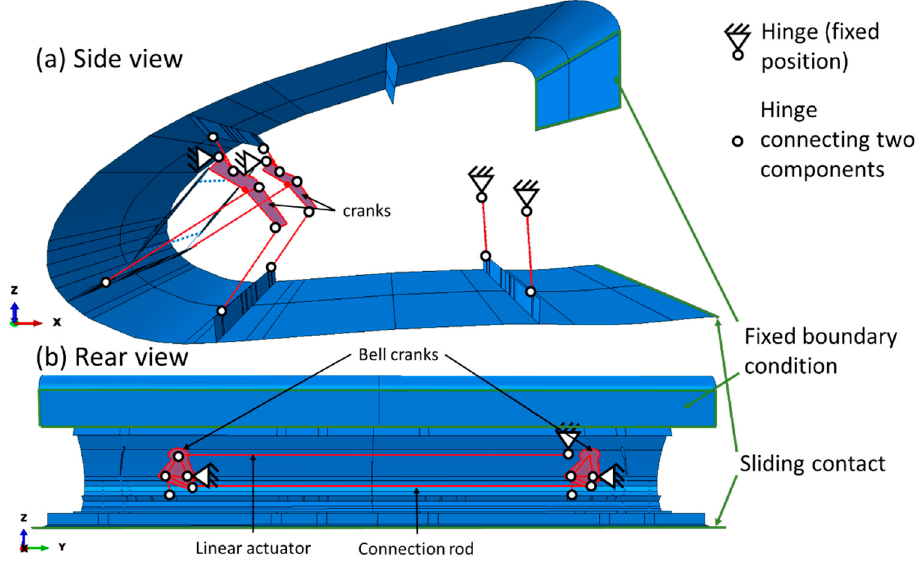
Figure 15. FE (finite element) model of the morphing leading edge (MLE) system shown from two different perspectives: ( a ) side view, ( b ) rear view.